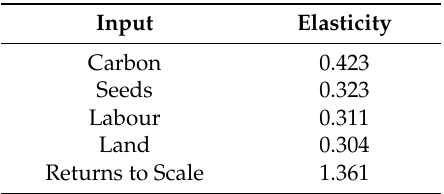
Table 3. Output elasticities and returns to scale.